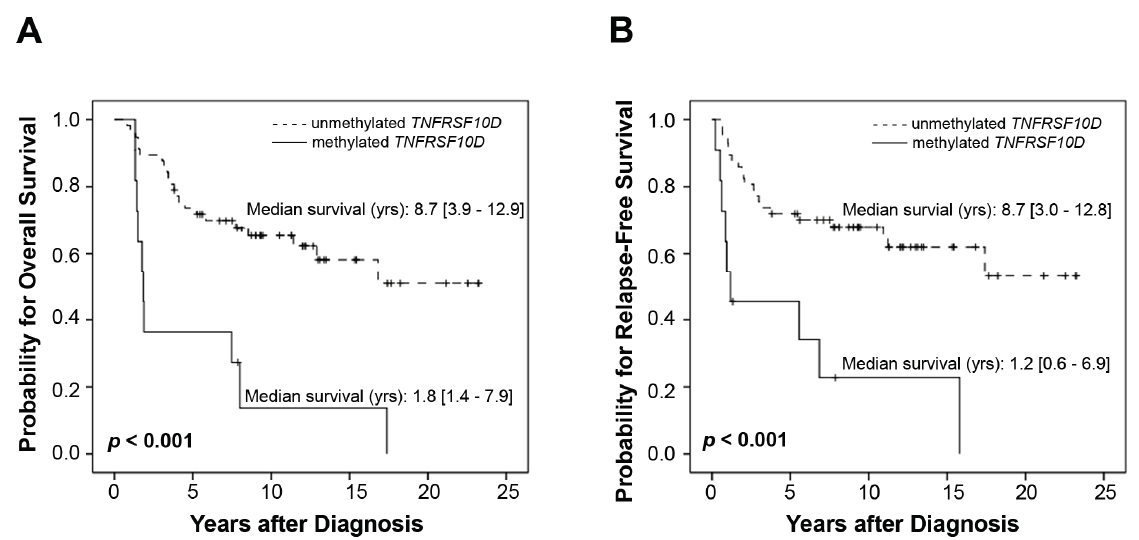
Figure 1. Kaplan–Meier survival analysis: ( A ) the overall survival and ( B ) relapse-free survival of 68 melanoma patients.